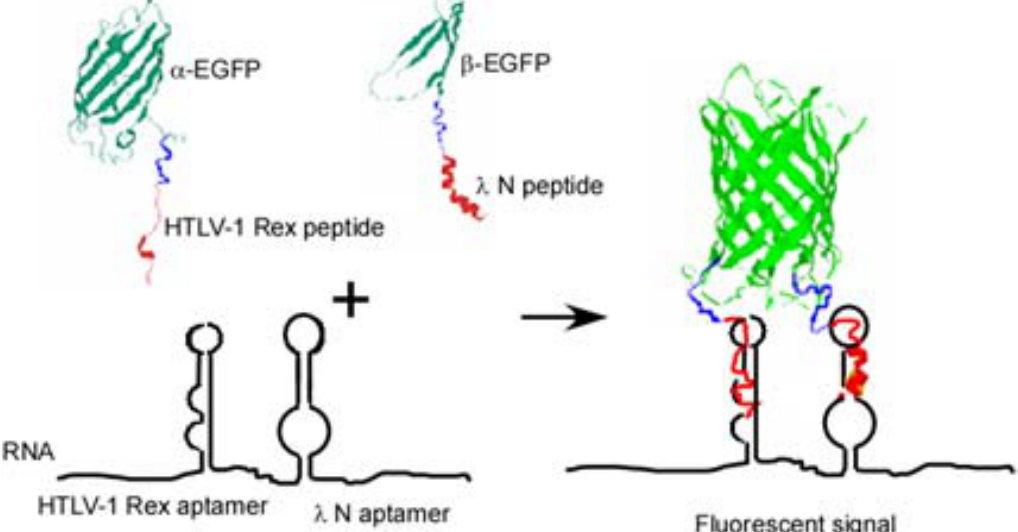
Figure 1. Fluorescent protein complementation based on binary peptide-RNA aptamer interactions. Two fragments of EGFP, α - and β -, are fused with the two viral peptides, HIV-1 Rex peptide and bacteriophage λ N peptide. In the presence of an RNA transcript bearing two corresponding aptamers, the two peptides interact with their cognate aptamers and bring together two fragments of split EGFP. Re-assembly of EGFP results in fluorescent